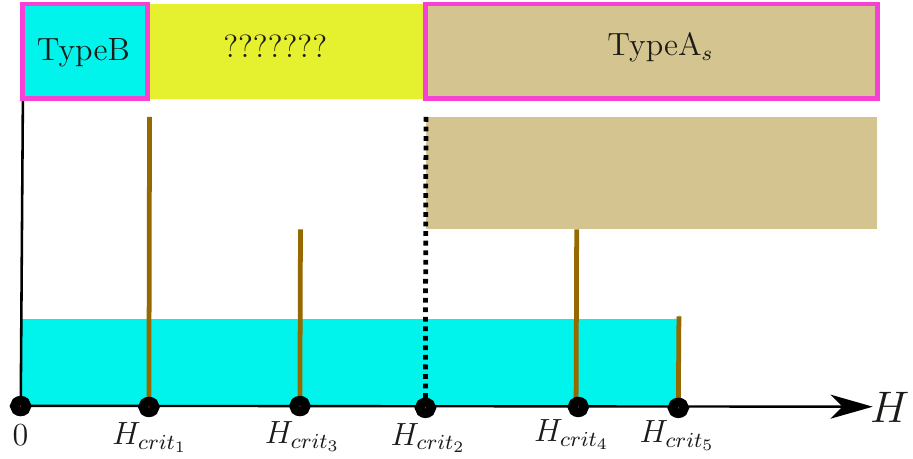
Figure 2 . Diagonal blue shaded regions indicate: perturbative instability of TypeA s cascading gauge theory DFP for H < H , and perturbative instability of TypeA cascading gauge theory crit 3 b DFP, whenever it exists. Horizontal green shading for H indicates TypeA crit 2 < H < H crit 3 s cascading gauge theory DFP which is while perturbatively stable, is unstable to sufficiently large amplitude chiral symmetry breaking fluctuations. The cascading gauge theory states in de Sitter with H < H evolve to de Sitter vacuum, TypeB-labeled bordered rectangle. The cascading crit 1 gauge theory states in de Sitter with H > H evolve to TypeA DFP. The late-time dynamics of crit 2 s the cascading gauge theory states for H , the yellow rectangle, is crit 1 < H < H crit 2